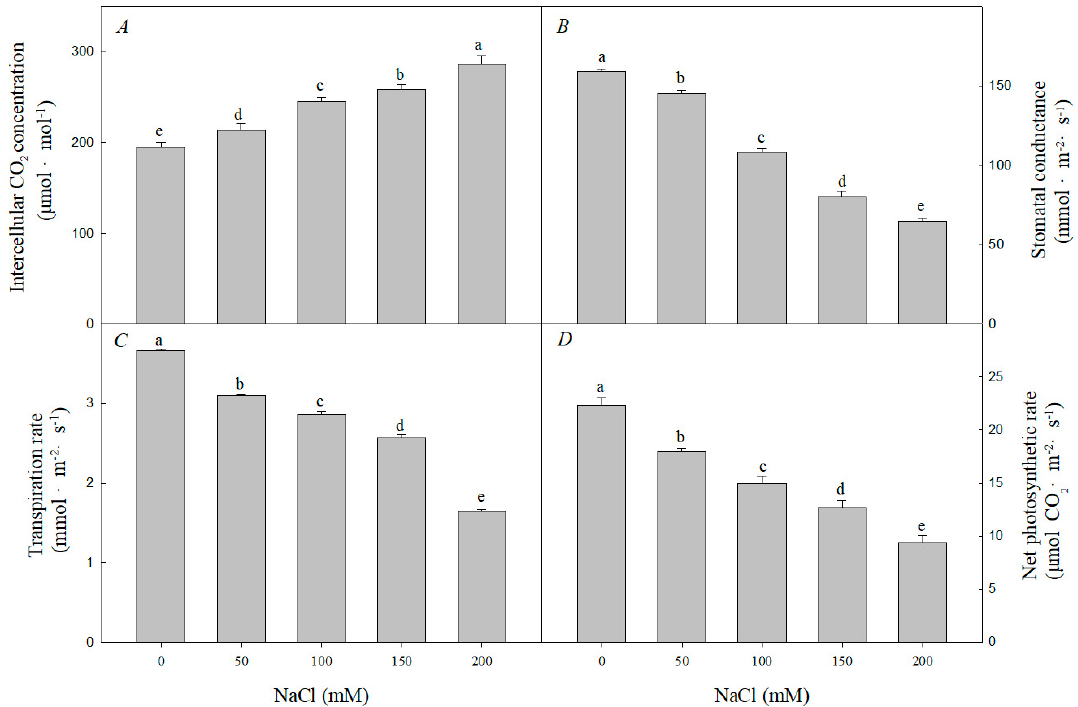
Figure 6. Effect of NaCl stress on photosynthesis of R. pseudoacacia seedlings. ( A ) Intercellular CO2 concentration; ( B ) stomatal conductance; ( C ) transpiration rate; ( D ) net photosynthetic rate. Values are mean ± SD of five biological replicates. Bars with different letters are significantly different at p < 0.05 according to Duncan’s multiple range tests. With increasing salt concentrations, total chlorophyll, chlorophyll a, and chlorophyll b contents significantly decreased compared to the control (Figure 7). At 200 mM NaCl, the total chlorophyll, chlorophyll a, and chlorophyll b contents were 55.2%, 47.1%, and 48.7% of the control group abundances, respectively.